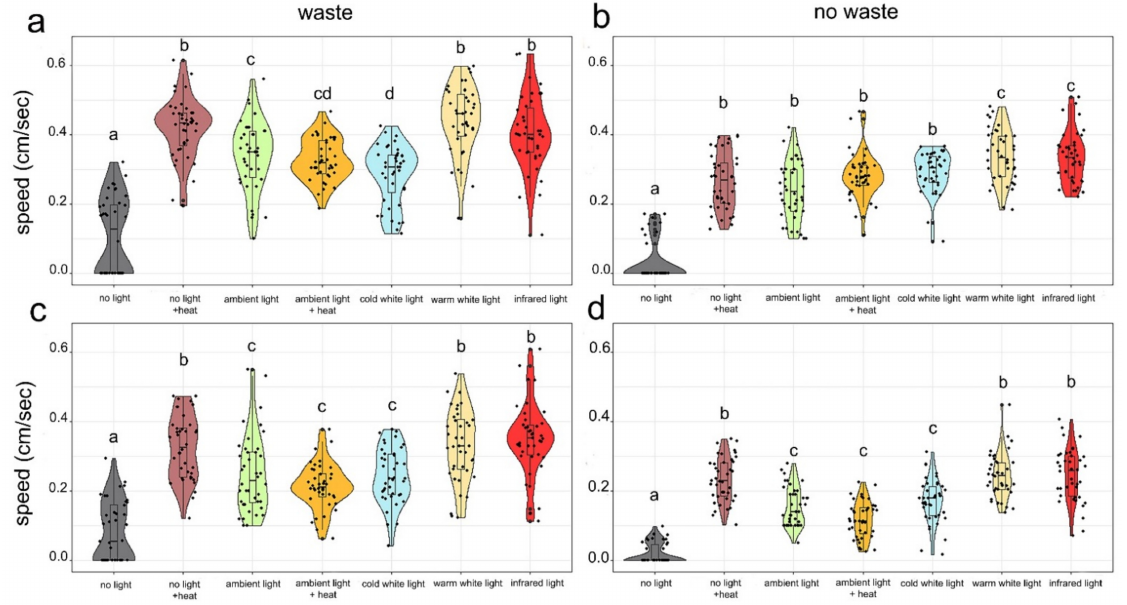
Figure 5. Locomotory speed of 6th instar larvae (above: a , b ) and prepupae (below: c , d ) under different stress conditions. Different letters highlight statistically different groups according to pairwise comparisons. Violins show the probability density of the data at different